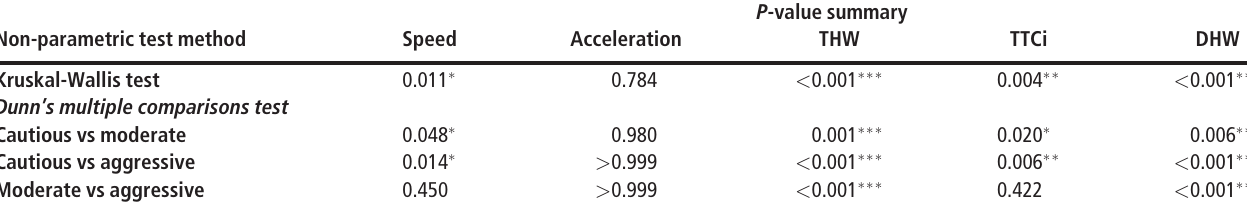
Table 10 Non-parametric test of one-way ANOVA results Non-parametric test